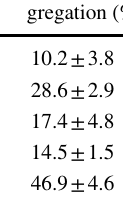
potency of compounds 1 – 4 (25 μM) on the Cu 2+ -induced A β 1−42 aggregates